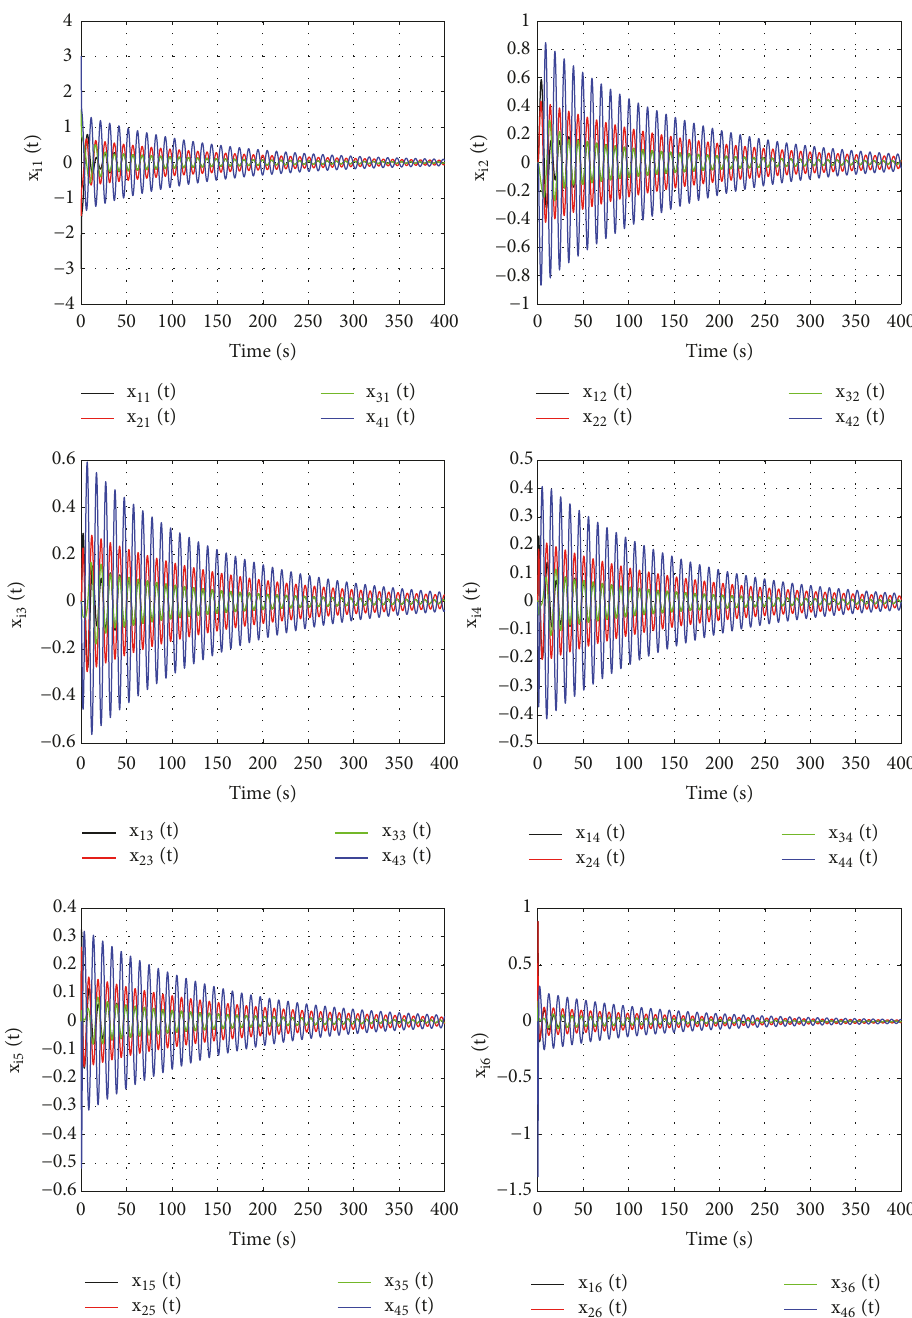
Figure 6: The trajectories of all agents’ states in the FOMAS with sextuple integral and symmetric time-delays when all 𝜏 𝑚 < 𝜏 in Example 3.